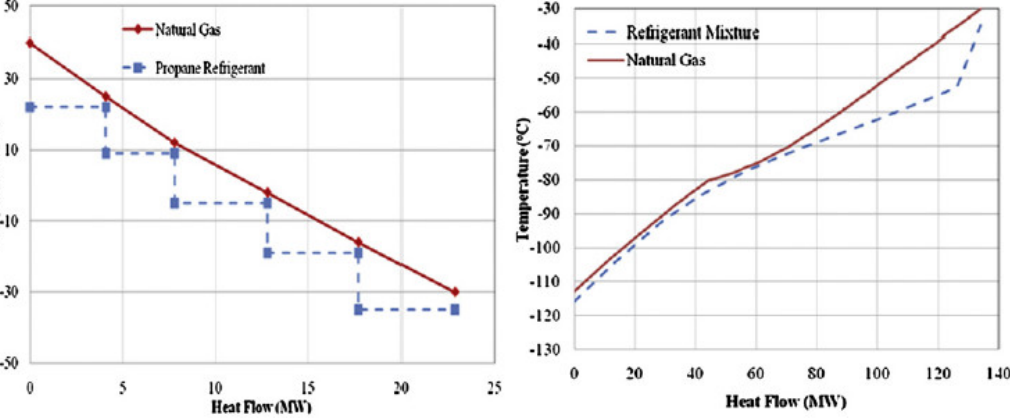
Figure 46. Temperature profile in single refrigerant heat exchangers ( left ) and in a mixed refrigerant heat exchanger with 1 K pinch temperature ( right ) [175]. Reproduced with permission from Elsevier (license number